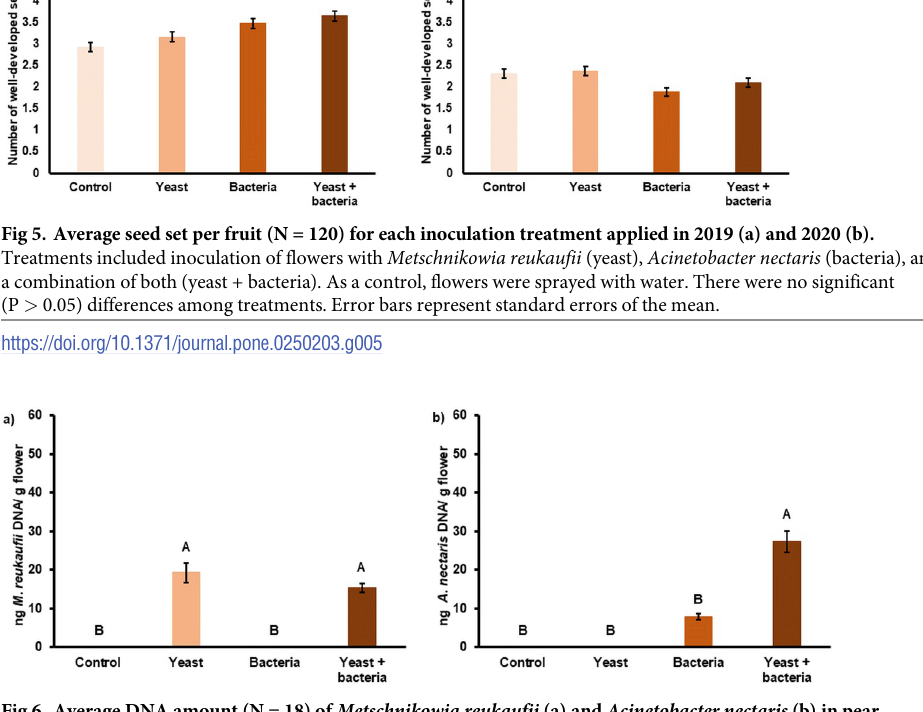
Fig 6. Average DNA amount (N = 18) of Metschnikowia reukaufii (a) and Acinetobacter nectaris (b) in pear flowers one day after inoculation. Treatments included inoculation of flowers with M . reukaufii (yeast), A . nectaris (bacteria), and a combination of both (yeast + bacteria). As a control, flowers were sprayed with water. Treatments with different letters differ significantly (P < 0.05). Error bars represent standard errors of the mean.